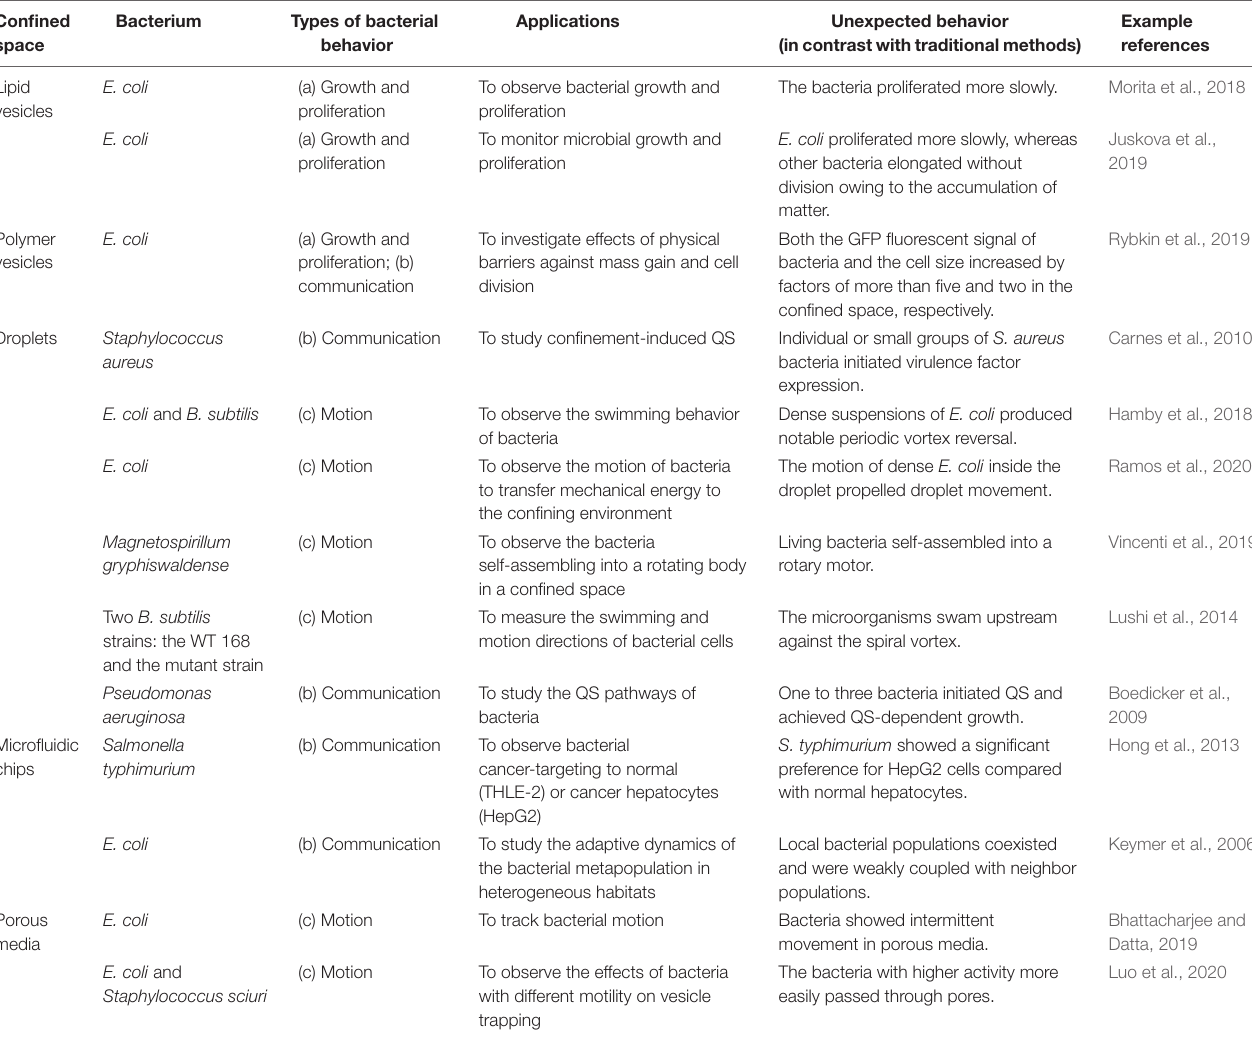
TABLE 1 | Types of bacterial behaviors inside confined